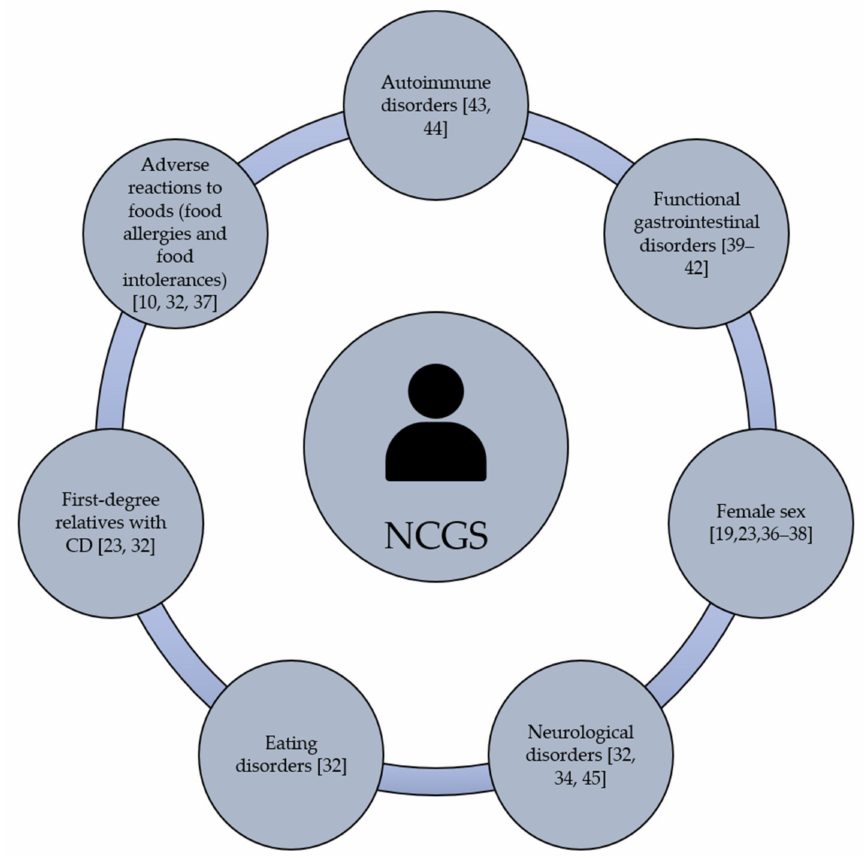
Figure 1. Potential predisposing factors of